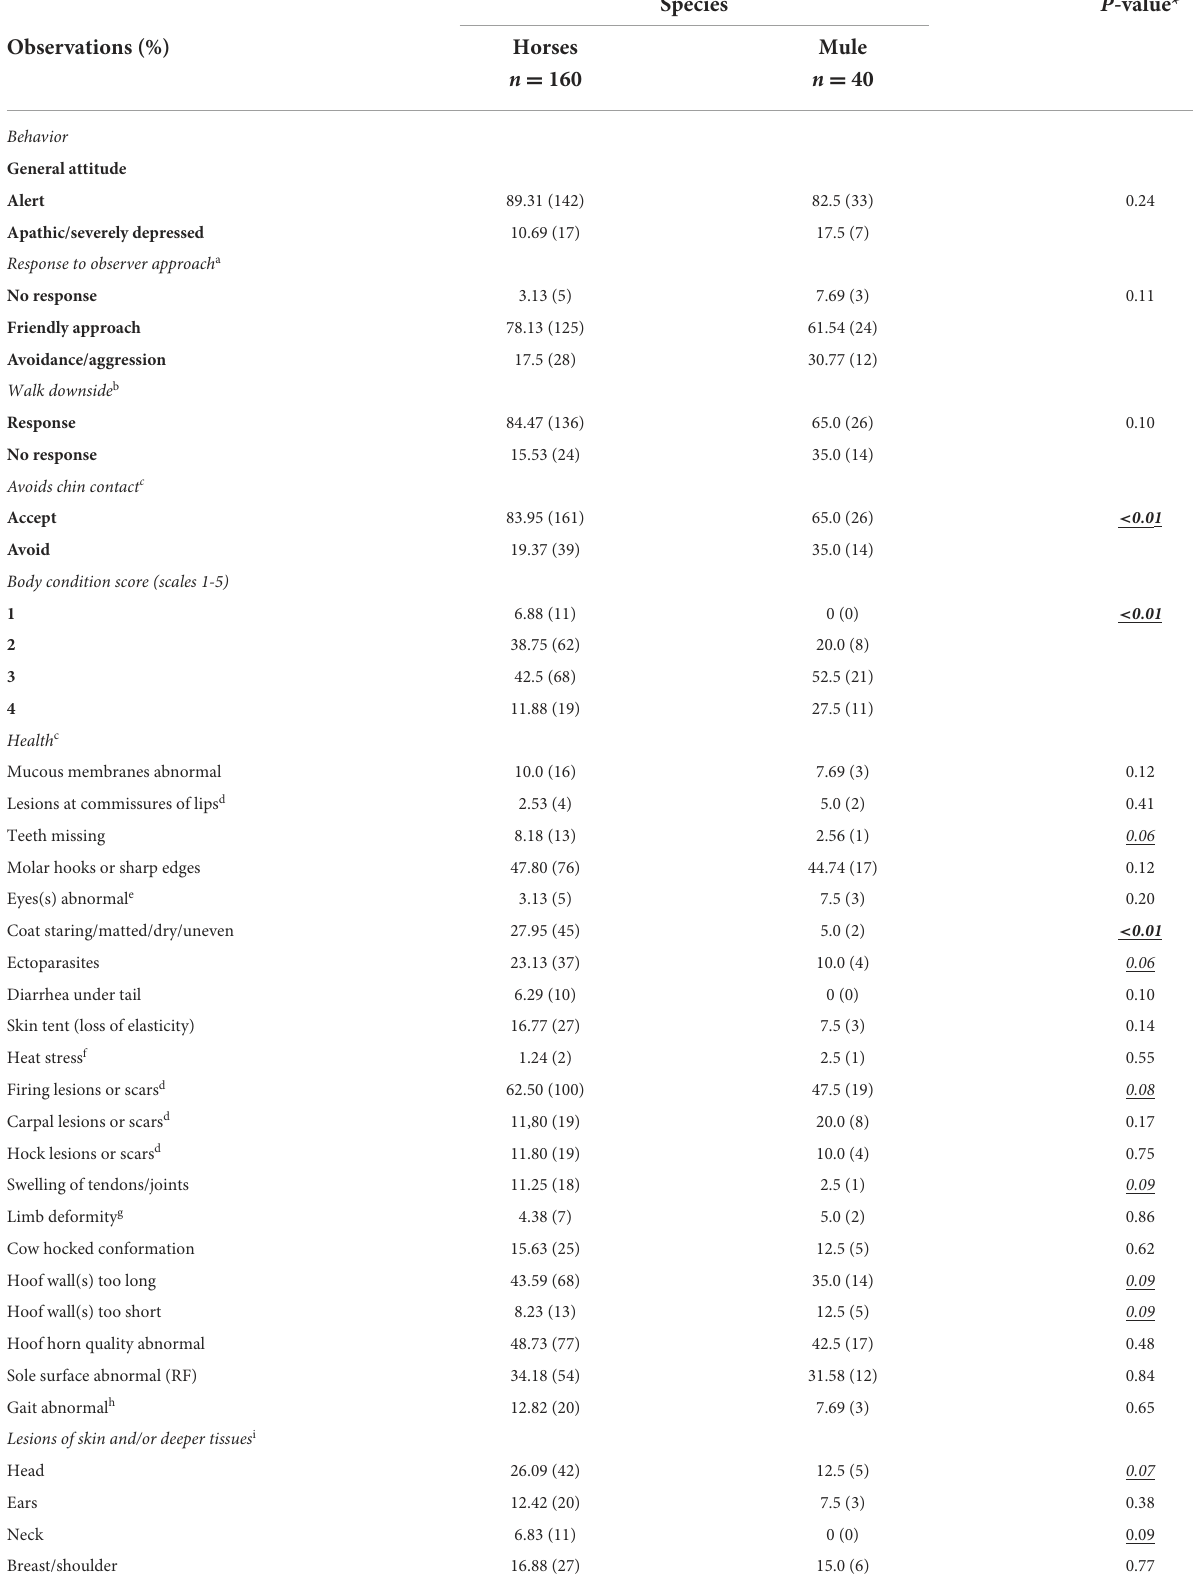
TABLE 3 Frequency (%) of behavior and health parameters of working horses and mules ( n =